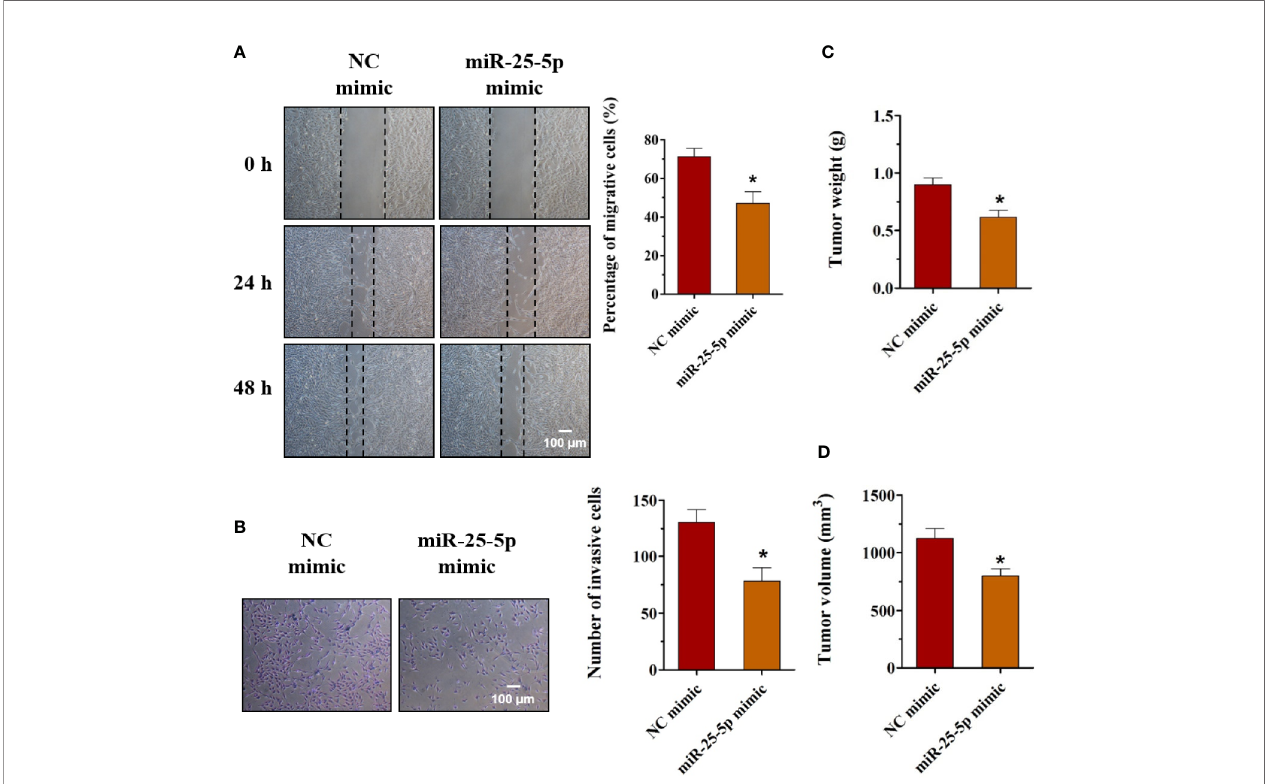
FIGURE 4 | Upregulation of miR-25-5p suppresses the migration, invasion, and tumor formation of OSCC cells. (A) Wound healing assay was used to determine the migration of SCC9 cells transfected with miR-25-5p mimic or NC mimic (n=4). (B) SCC9 cells were transfected with miR-25-5p mimic or NC mimic and allowed to migrate through an 8 µm pore size polycarbonic membrane in Transwell chambers. The invasive cells were stained and counted (n=4, Scale bar, 100 m m). (C, D) Animal experiments of tumor formation of OSCC cells were conducted using SCC9 cells. Tumor weights and volumes were measured (n=10, Student ’ s t-test, *p <